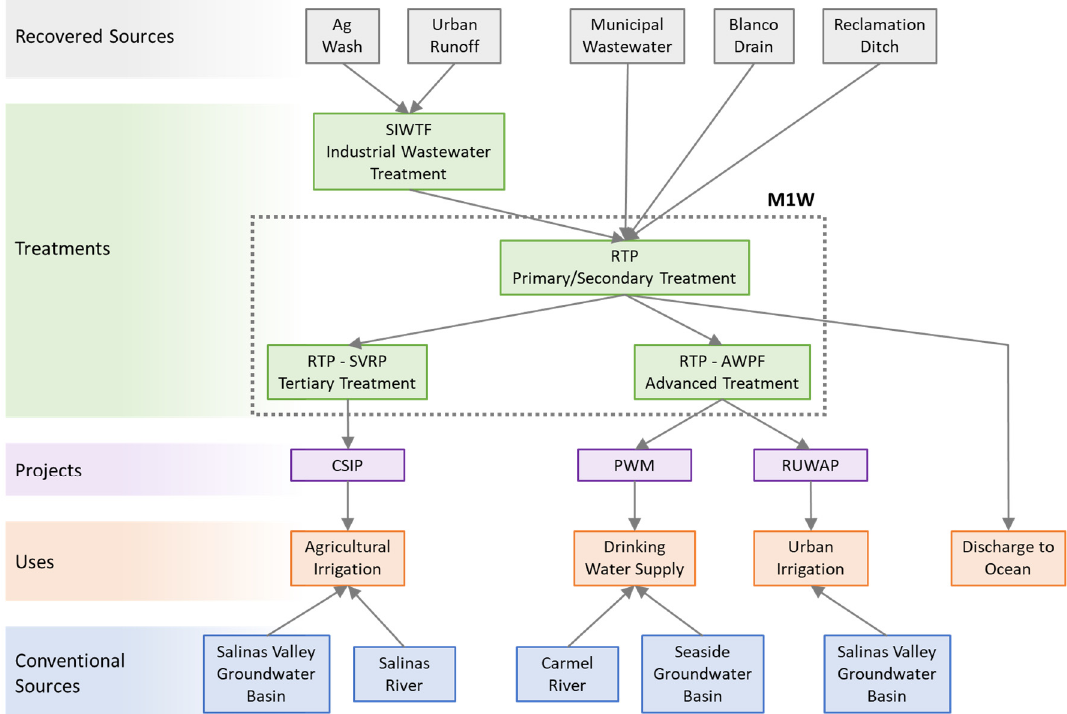
Figure 4. Conceptual diagram of Monterey’s regional recycled water network, including water sourcing, treatment, and use. (Legend: SIWTF = Salinas Industrial Wastewater Treatment Facility, RTP = Regional Treatment Plant, SVRP = Salinas Valley Reclamation Project, AWPF = Advanced Water Purification Facility, CSIP = Castroville Seawater Intrusion Project, PWM = Pure Water Monterey, RUWAP = Regional Urban Water Augmentation